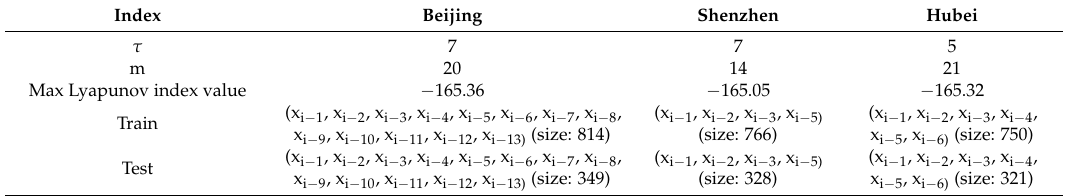
Figure 9. ( a ) The result of the PACF analysis of sub4 after processing by EMD of the Beijing carbon price; ( b ) The result of the PACF analysis of A1 after processing by WT of the Beijing carbon price. Table 6. The parameters of the approximation subsequences decomposed by wavelet transform (WT).